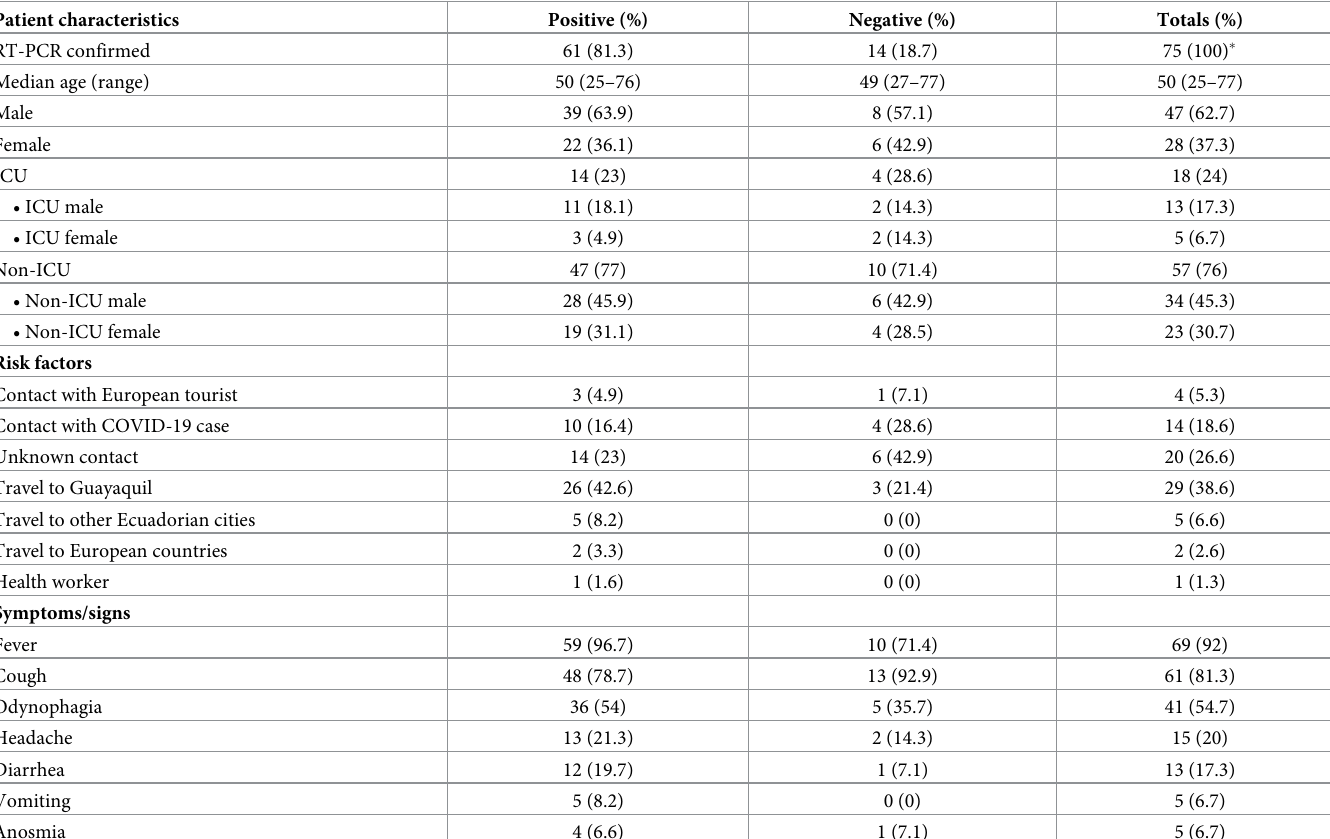
Table 1. General characteristics, risk factors, and symptoms/signs of the first laboratory tested COVID-19 cases (n = 75) attended in the Hospital General del Sur de Quito (HGSQ), Quito, Ecuador—March 2020.